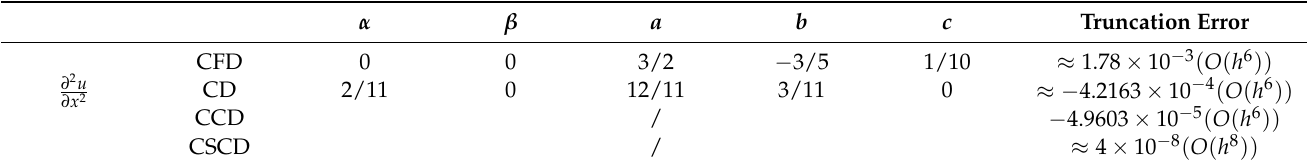
Table 1. Truncation errors in various difference schemes for the second-order derivative